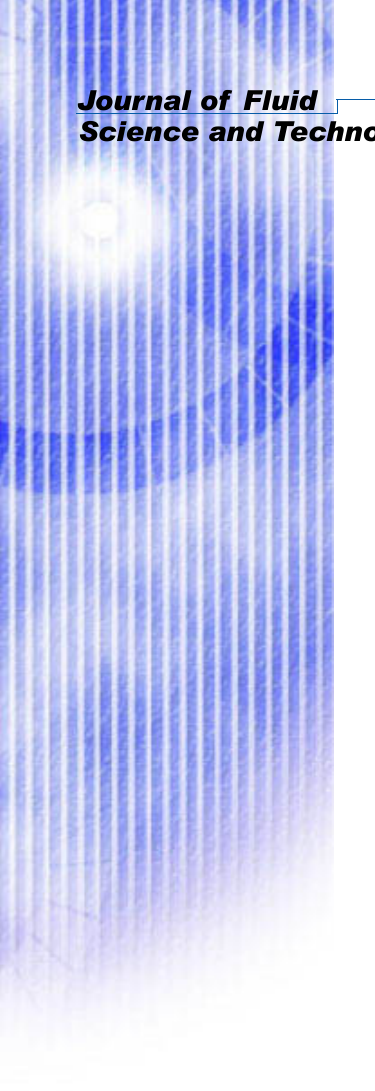
Fig. 8 Plots of azimuthal velocity in the r-z plane ( ∆ v=2.7 × 10 -3